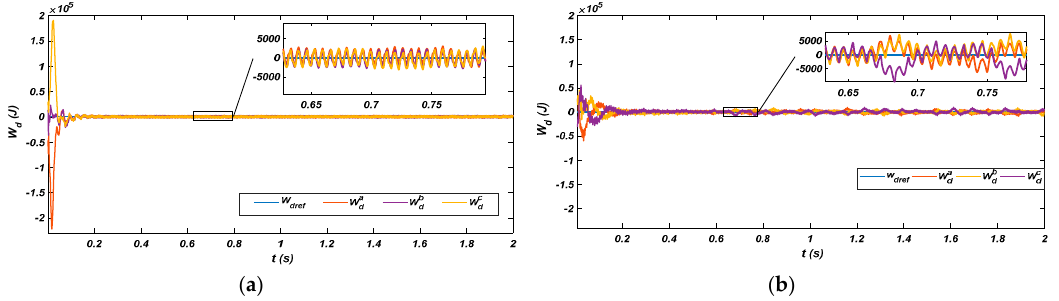
Figure 15. ( a ) Energy difference of arms using the API controller; ( b ) energy difference of arms using the PR controller.